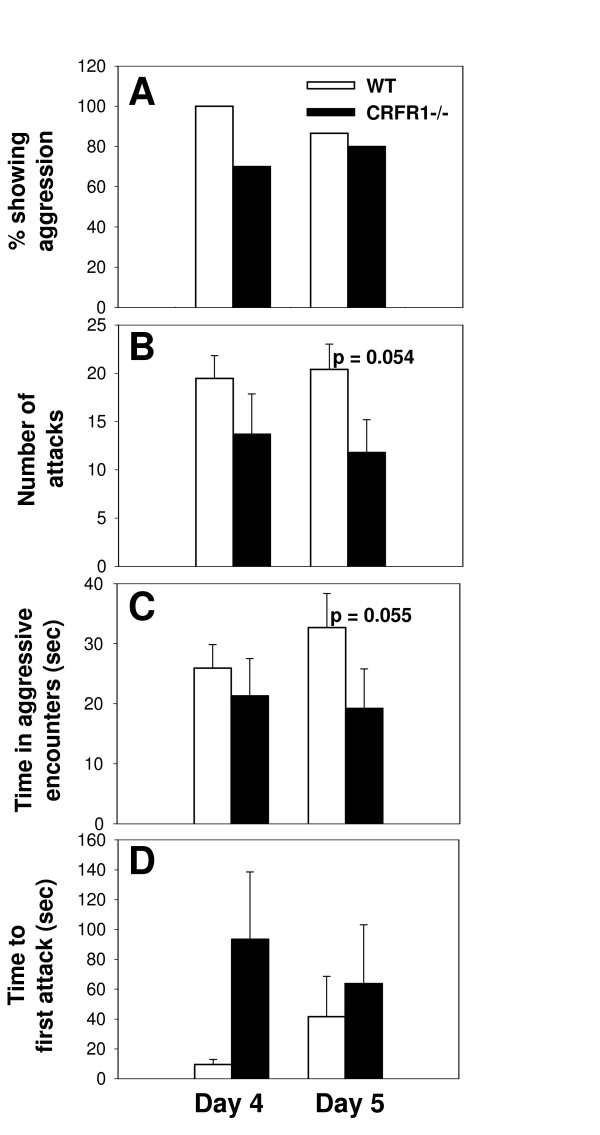
Analysis of maternal aggression in WT and CRFR1-/- mice. Using a resident-intruder paradigm, CRFR1-/- mice show decreased aggression relative to WT mice, but these difference do not reach significance in terms of the percentage of females showing any aggression (A), the average number of attacks (B), the average amount of time in aggressive encounters (C), and the average latency to first attack (D) when examined on either postpartum Day 4 or 5. Bars represent means ± SE. White bars indicate WT mice and black bars indicate CRFR1-/- mice. Data that were non-normally distributed were examined via non-parametric tests (see Methods and Results for more details). When a possible outlier from the CRFR1-/- was removed, significant differences in aggression were found for some measures (see Results for details).